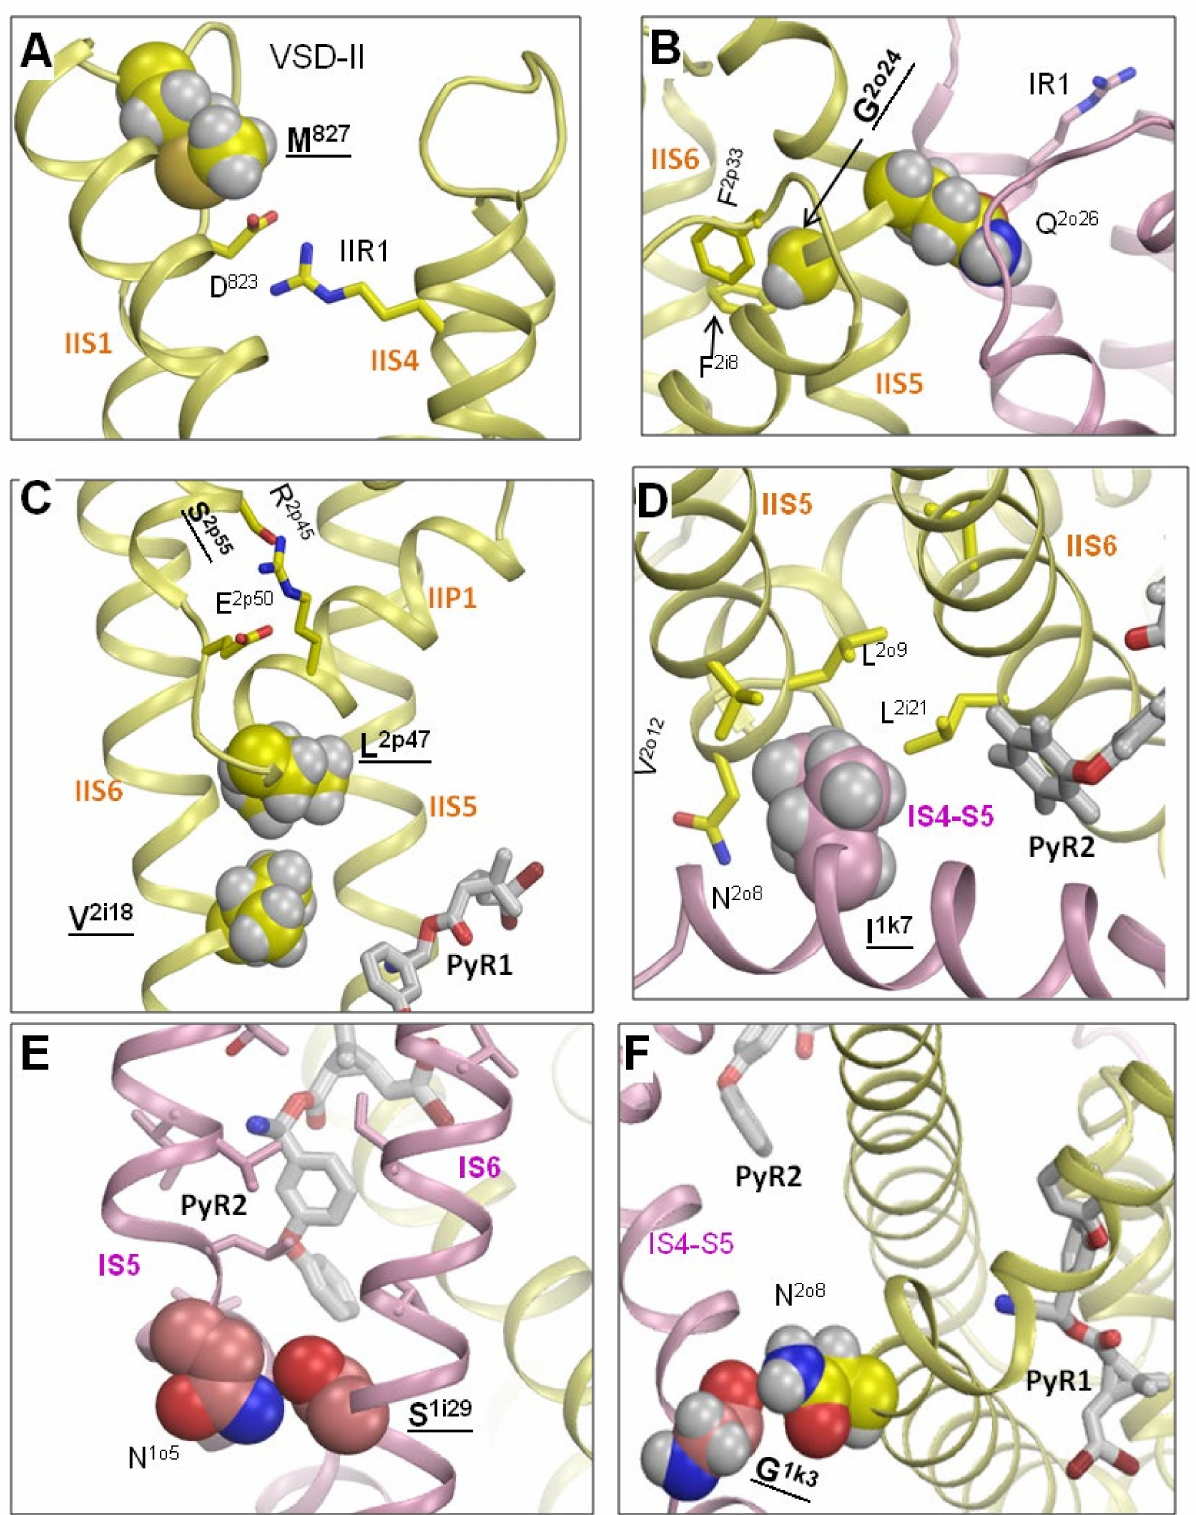
Figure 5. Residues beyond the PyR1 and PyR2 sites form intersegment contacts whose destruction would allosterically affect the action of pyrethroids. Labels of residues that are subject to kdr mutations are bold-underlined (see Section 3.6 for more detail). Panels ( A – F ) show, respectively, contacts of residues M 827 , G 2o24 , L 2p47/ S 2.p55 , I 1k7 , S 1i29 and G 1k3